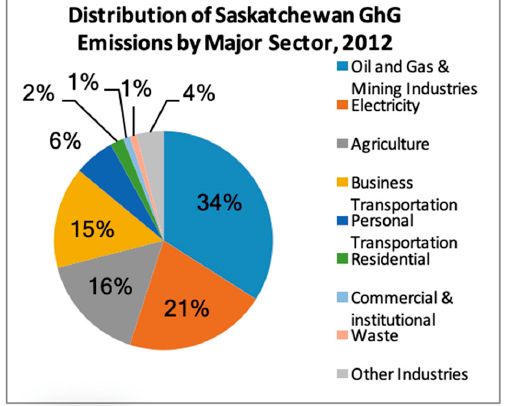
Figure 1. Distribution of Saskatchewan greenhouse gas (GHG) emissions by major sectors, 2012 [4].